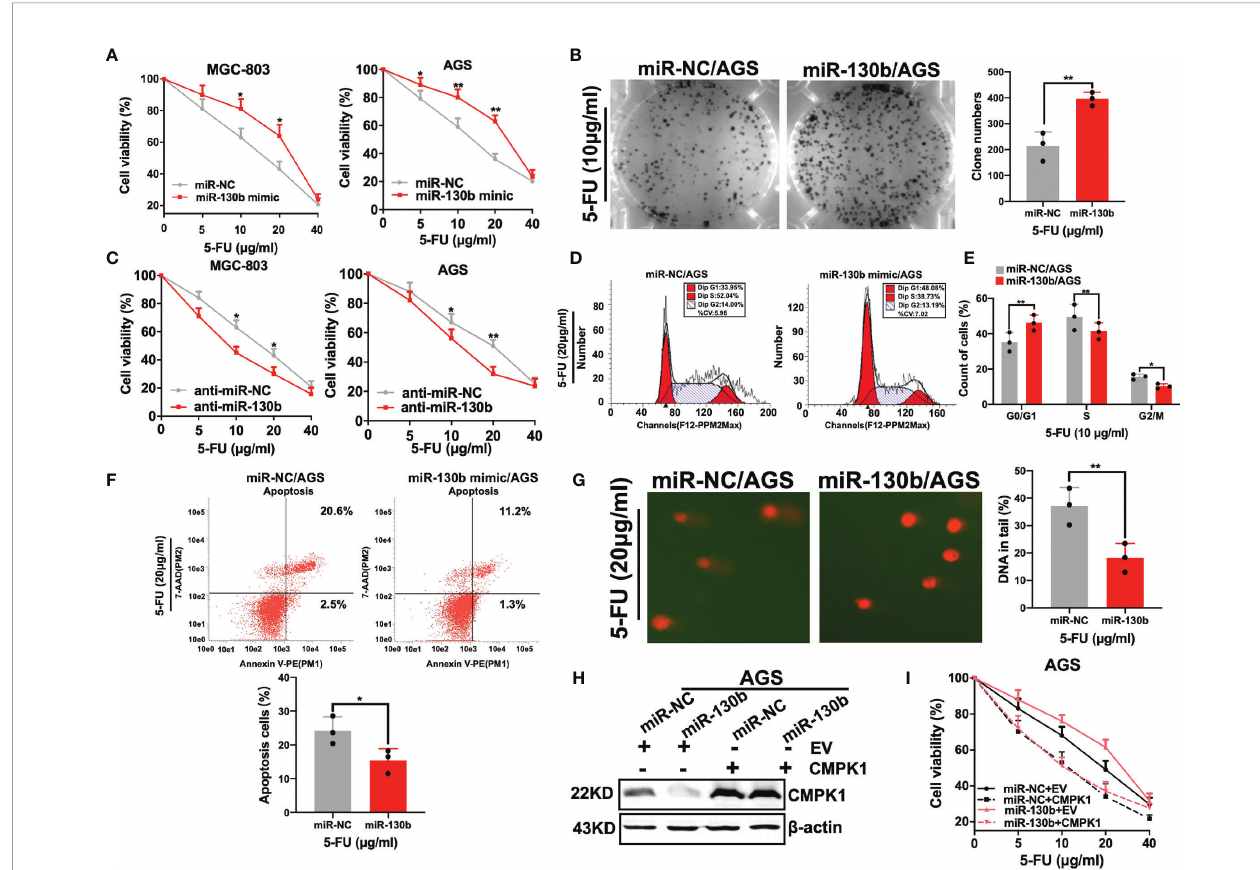
FIGURE 4 | MiR-130b has an in fl uence on 5-FU sensitivity. (A, B) AGS and MGC-803 cells were transfected with either miR-NC or miR-130b mimic for 48h, and cells were reseeded for 5-FU sensitivity detection using an MTT assay (A) and a clonogenic cell-survival assay (B) . (C) AGS and MGC-803 cells were transfected with either anti-miR-NC or anti-miR-130b upon 5-FU treated. Cell viability was assessed by MTT assay. (D – F) Cells in the apoptosis and cell-cycle analysis were pre- treated and measured by fl ow cytometry. AGS cells were used to determine the impact of miR-130b/control treated with 5-FU. The representative fl ow cytometry patterns of cell cycle distribution is shown in (D) and the statistical analysis is shown in (E) . The representative patterns of cell apoptosis are shown in ( F , upper panel) and the statistical analysis is shown in ( F , lower panel). (G) Overexpression of miR-130b in AGS cells and 5-FU caused DNA damage detected by comet assay. Representative images are shown in ( G , left panel) and the mean ± SD for each condition shown in ( G , right panel). (H, I) AGS cells were cotransfected with the CMPK1 CDS region or negative control vector together with 20 nM miR-NC or miR-130b. After 24 h, cells were harvested for western blot analysis (H) or reseeded for 5-FU sensitivity assay (I) . Data represent the mean ± SD, *P < 0.05; **P < 0.01, two-sided Student ’ s t